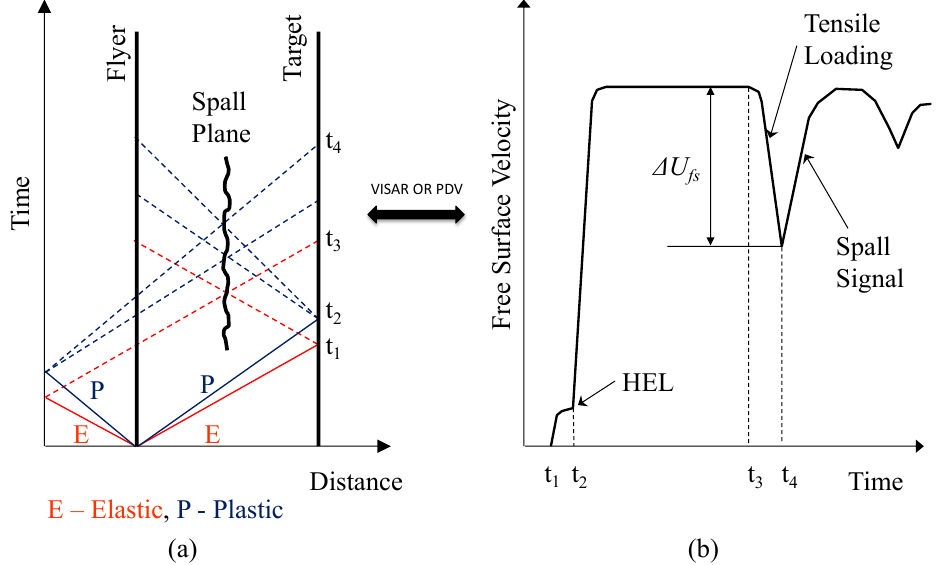
Figure 1. ( a ) A simplified Lagrangian (x-t) diagram describing a plate impact event and ( b ) the resulting breakout free surface velocity profile representation of the spall